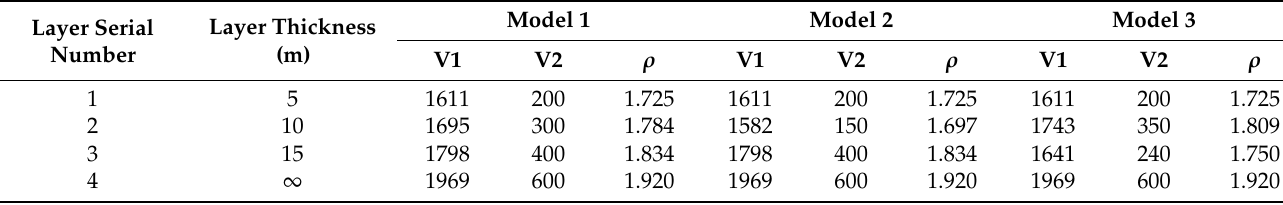
Table 1. Parameters of three geological models.